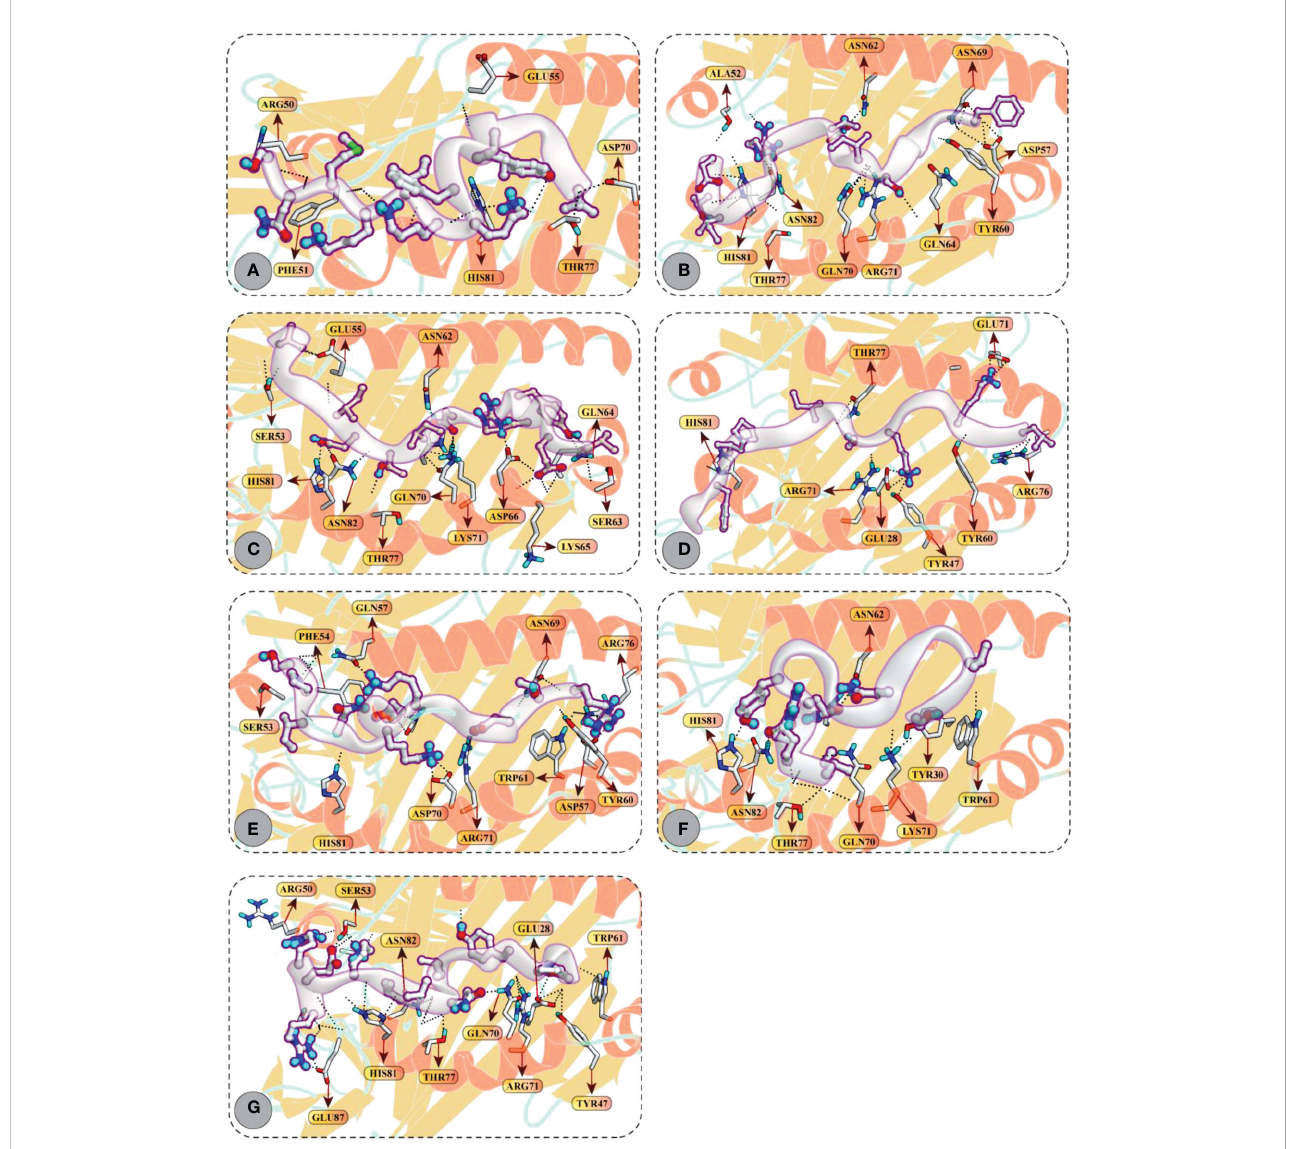
FIGURE 6 Molecular docking of HTL peptides and HLA class II molecules (A) Peptide LIVIIYVFKKIKMNS attached with the binding pocket of HLA-DRB1*11:01 (B) Peptide FGVYSILTSRGGITE attached with the binding pocket of HLA-DRB1*01:01 (C) Peptide VEVRYIDITNILGGV attached with the binding pocket of HLA-DRB1*04:01 (D) Peptide MNFIPIIYSKAGKIL attached with the binding pocket of HLA-DRB1*01:01 (E) Peptide SPINIETKKAISDTR attached with the binding pocket of HLA-DRB1*11:01 (F) Peptide IRDQYITALNHLVLS attached with the binding pocket of HLA-DRB1*04:01 (G) Peptide SLPYKYLQVVKQRER attached with the binding pocket of HLA-DRB1*01:01. All H-bonds are represented in dotted lines and the interacting residues of HLA class II molecule is shown in